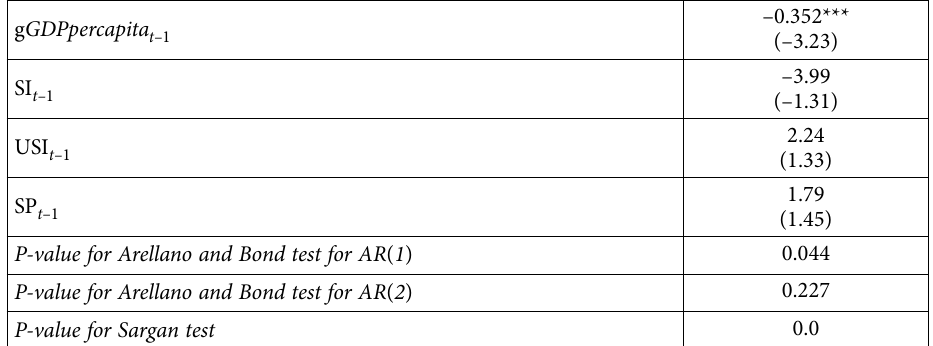
Table 3. Testing the impact of skilled and unskilled immigration on unemployment 1 (source: author own